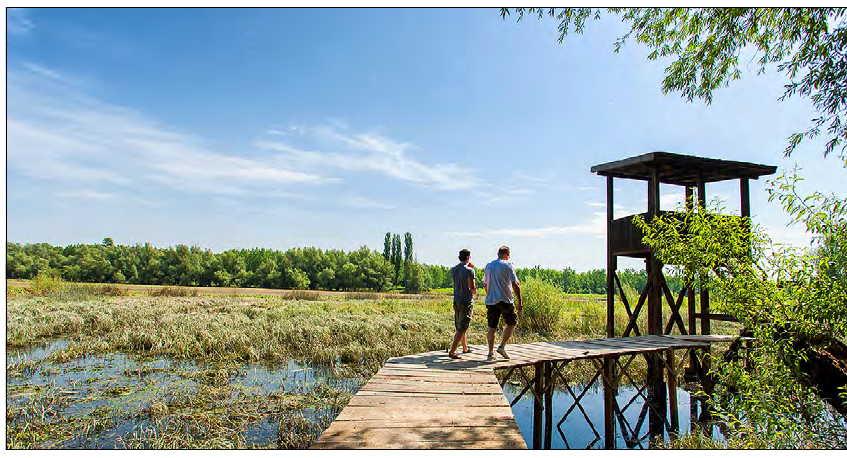
Figure 3. Inundation area of the Danube river